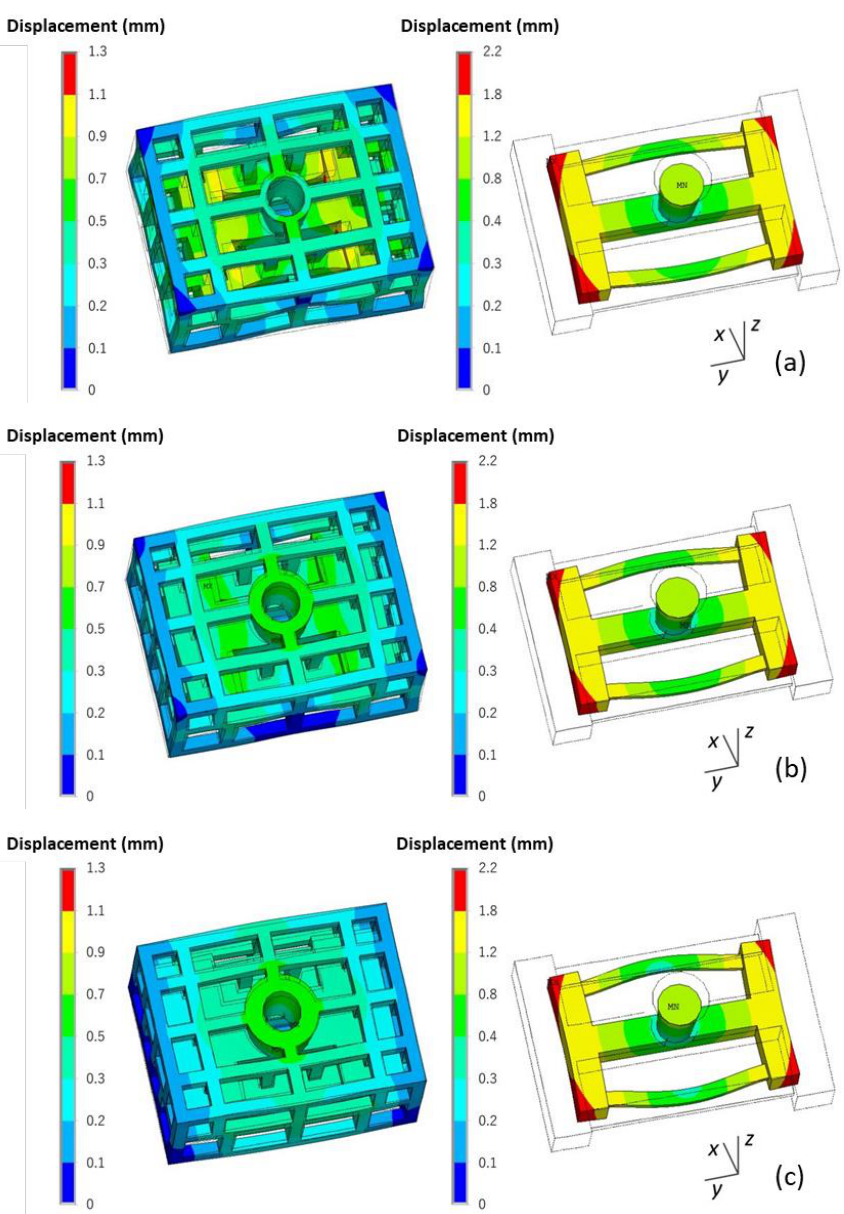
Figure 23. Comparison of the deformation (equivalent displacement and deformed geometry) of skeletal sand molds and castings using a skeletal sand mold of different shell thicknesses: (a) 10 mm; (b) 20 mm and (c) 30 mm